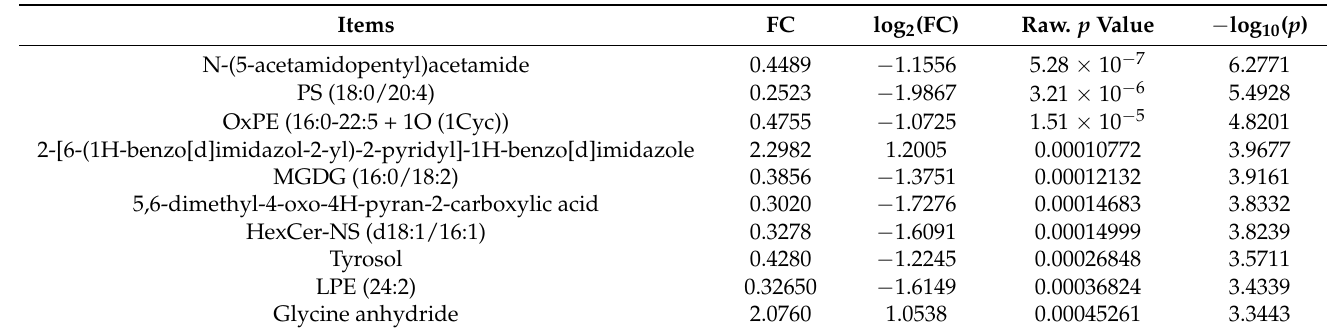
Table 2. Top 10 differential yolk metabolites identified between male and female chicken embryos at E7.